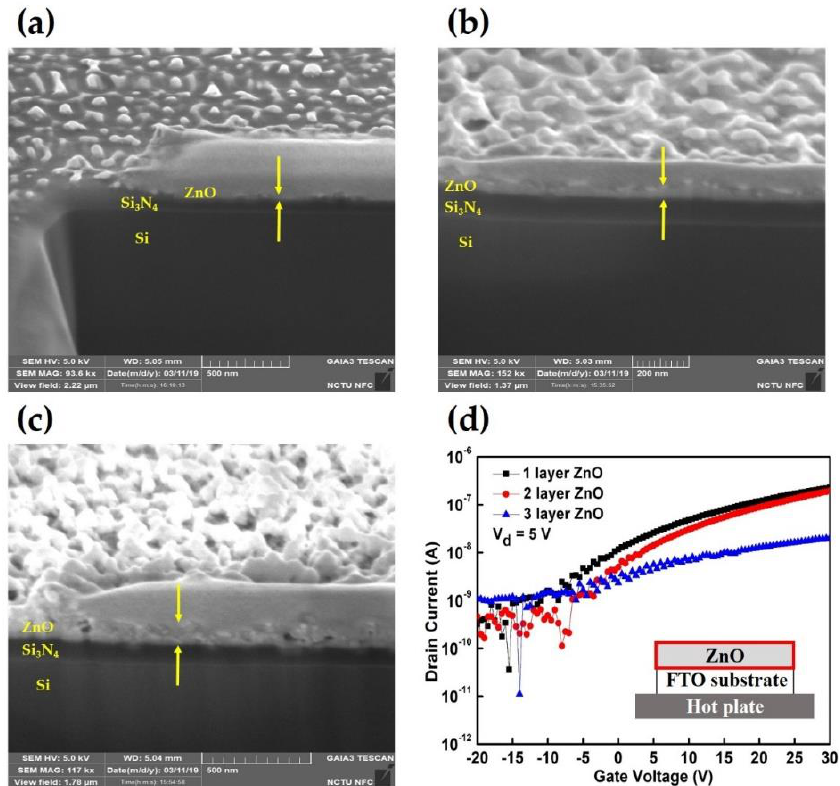
Figure 2. Focus ion beam cross-section images of the ZnO-based TFTs with the ZnO channel layer sprayed ( a ) once, ( b ) twice, and ( c ) thrice; ( d ) typical transfer characteristics of drain-source current versus gate voltage (I DS -V GS ) of ZnO-based TFTs with ZnO channel layers that have thicknesses of 15.98, 28.54, and 58.90 nm.